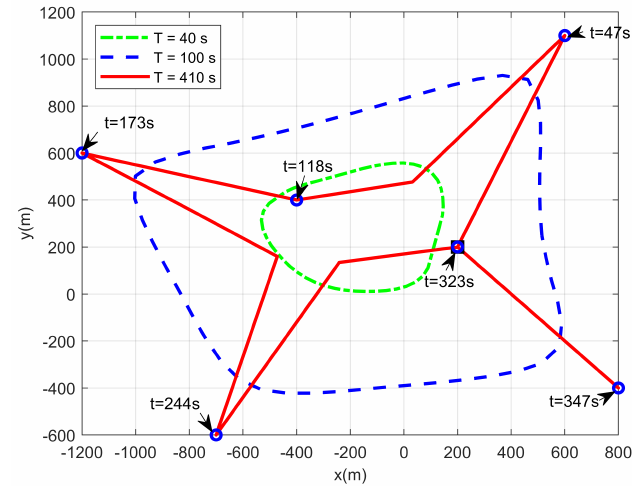
Figure 2. The real − time trajectory of a single UAV.